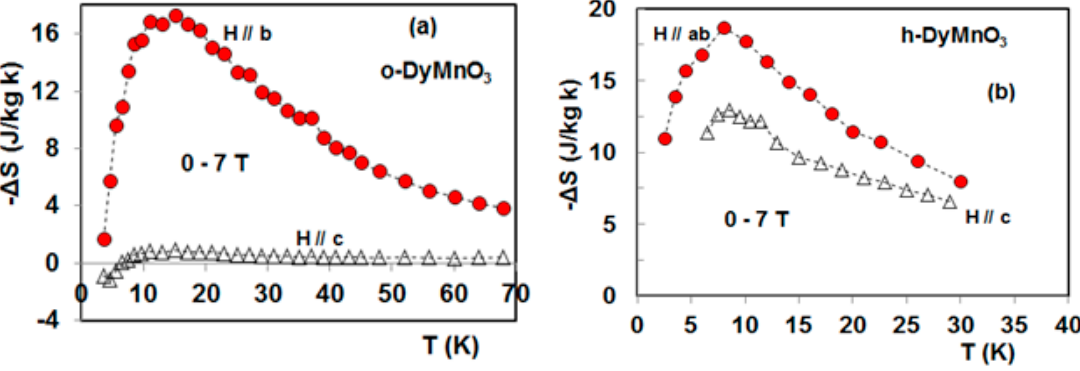
Figure 6. Isothermal entropy change as a function of temperature under a magnetic field change of 7 T along the easy and hard-directions of orthorhombic ( a ) and hexagonal ( b ) DyMnO 3 single crystals [22,24].